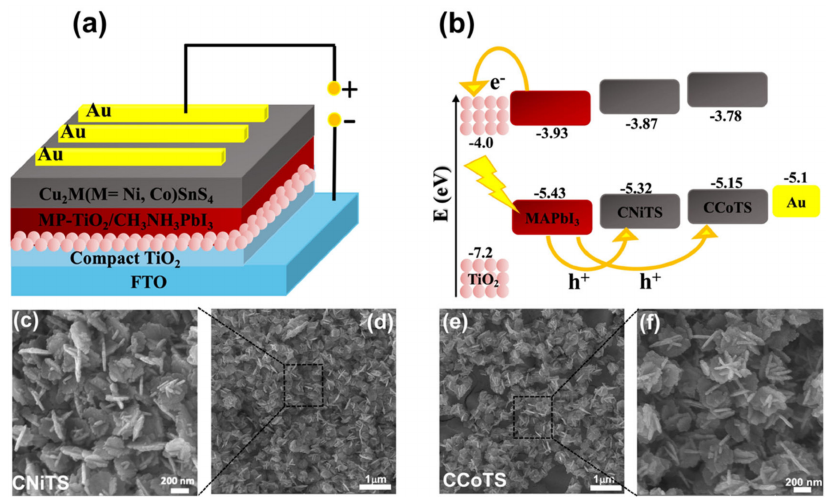
Figure 1. ( a ) Schematic and ( b ) band diagram energy level of perovskite solar cells (PSCs), top-view field-emission scanning electron microscopy (FESEM) images of ( c ), ( d ) Cu 2 NiSnS 4 (CNiTS) and ( e ), ( f ) Cu 2 CoSnS 4 (CCoTS) layer (deposited by 100 mg mL − 1 ink concentration for CNiTS and CCoTS)